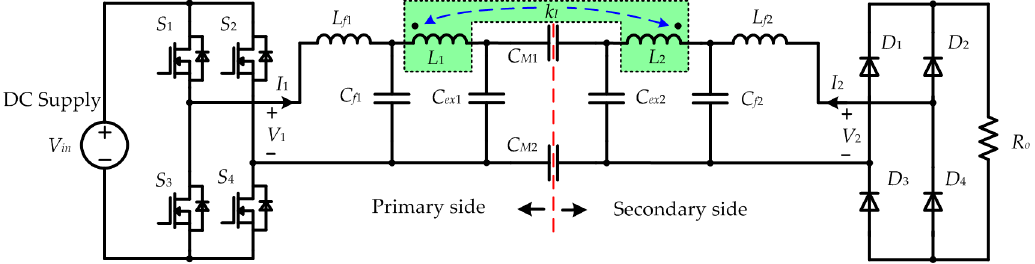
Figure 28. Circuit topology of an IPT-CPT combined system.